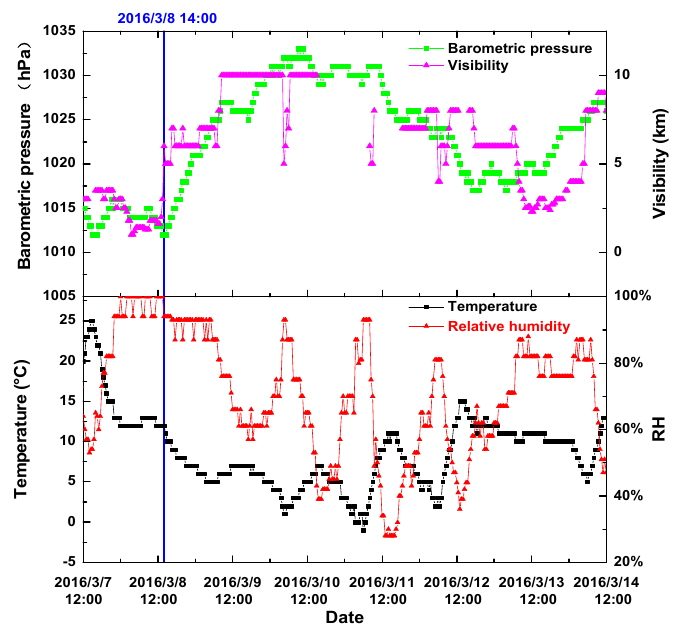
Figure 11. Meteorological parameters during the measurement period: Temperature, RH, visibility and barometric pressure.